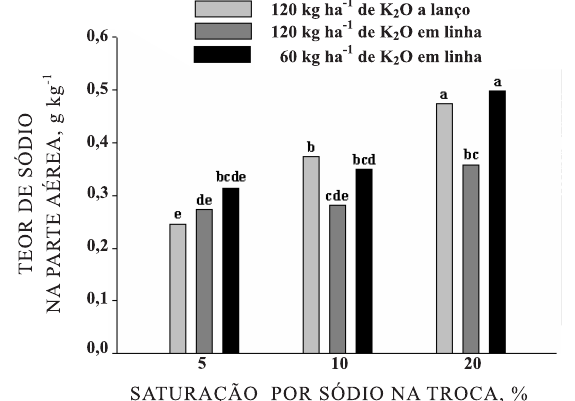
Figura 2. Teor de sódio na parte aérea de plântulas de arroz, em função do manejo da adubação potássica e dos níveis de salinidade no solo. Médias seguidas pela mesma letra não diferem entre si pelo teste DMS, a 5